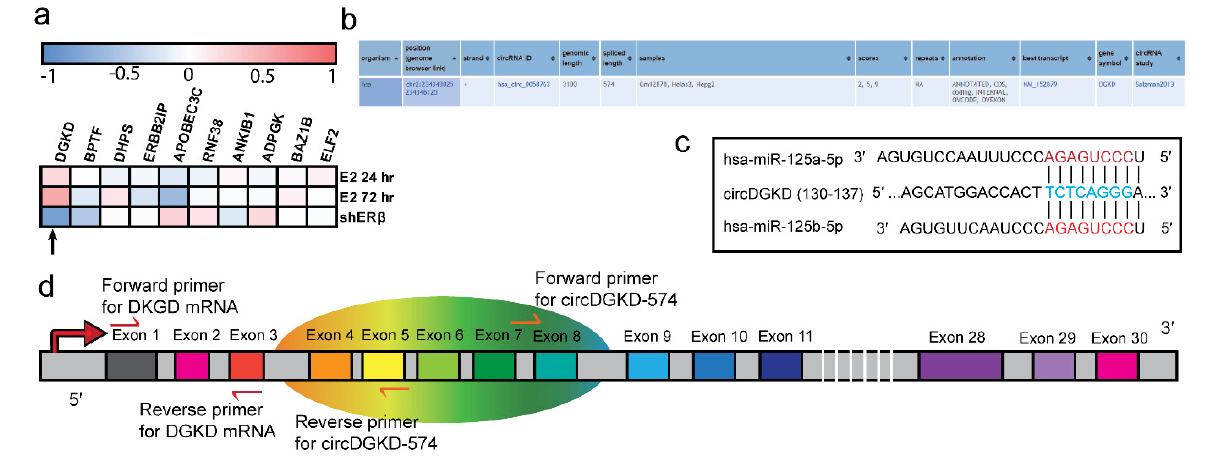
Figure 3. ER β increases circDGKD that sponges miRNA-125-5p in RCC. ( a ) RNASeq analysis of the gene expression of the top 10 potential circRNA candidates that might sponge miR-125-5p. ( b ) De- tailed information about circDGKD retrieved from Circbase. ( c ) Binding site information of miR- 125-5p with the circDGKD from Starbase. ( d ) Schematic diagram demonstrating the structure of